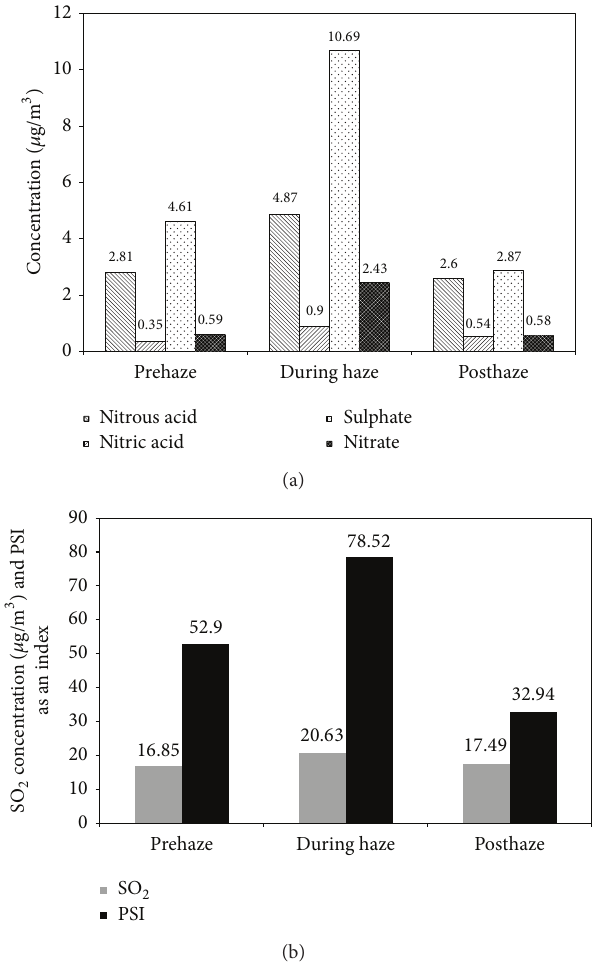
Figure 2: Daily mean concentrations of air pollutants and PSI during different time periods: (a) HONO, HNO 3 , SO 42− , and NO 3− and (b) SO 2 and